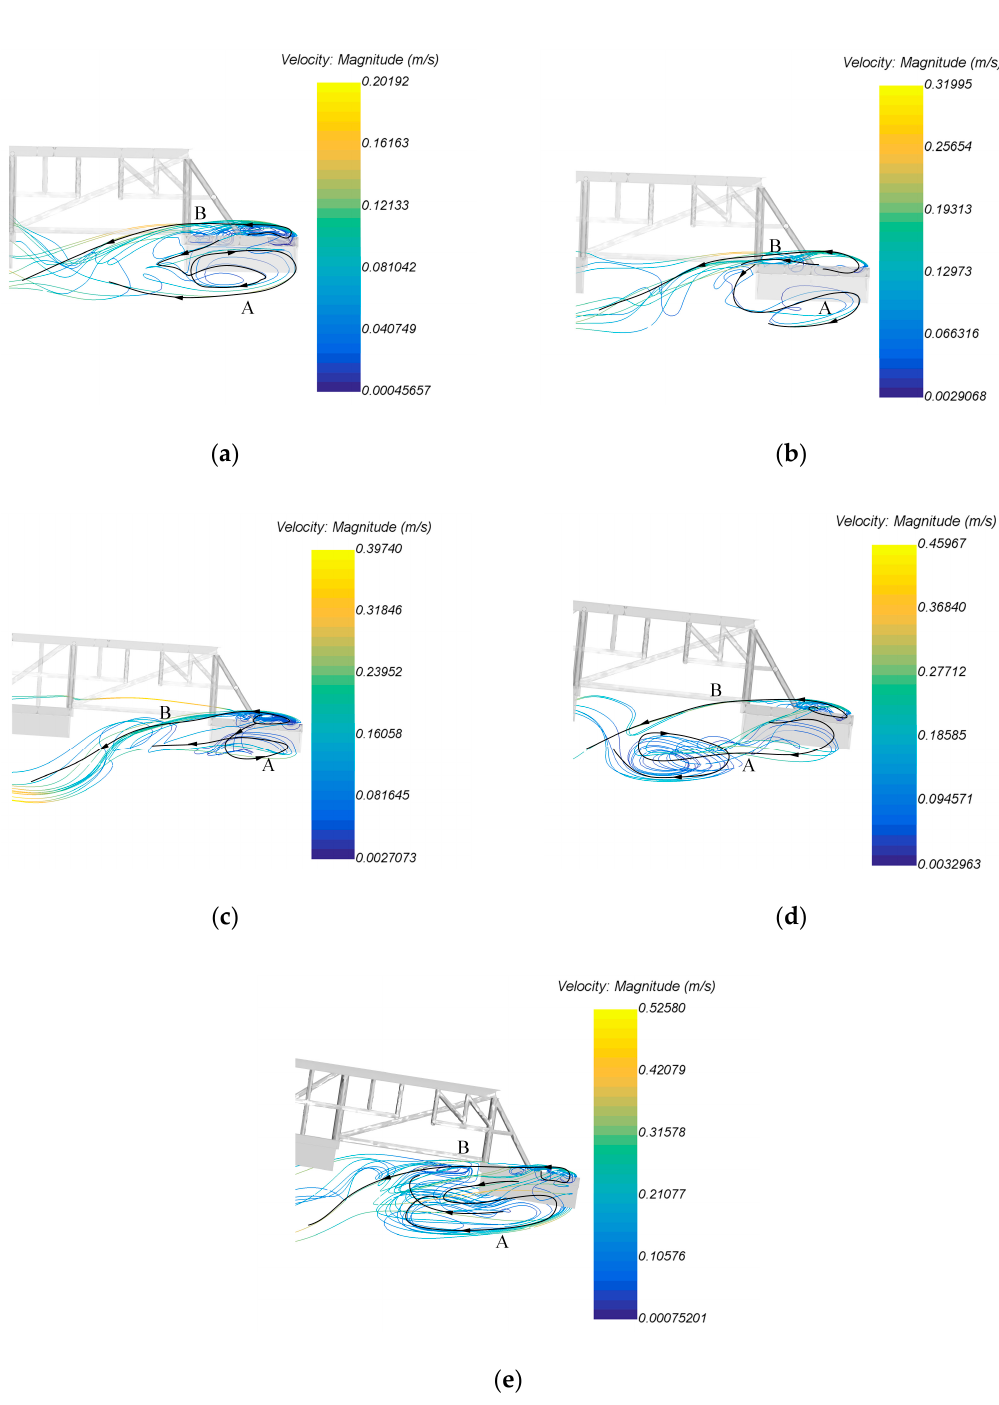
Figure 18. Flow patterns in the inlet section for the Y-direction towing cases: ( a ) Case 6, ( b ) Case 7, ( c ) Case 8, ( d ) Case 9, and ( e ) Case